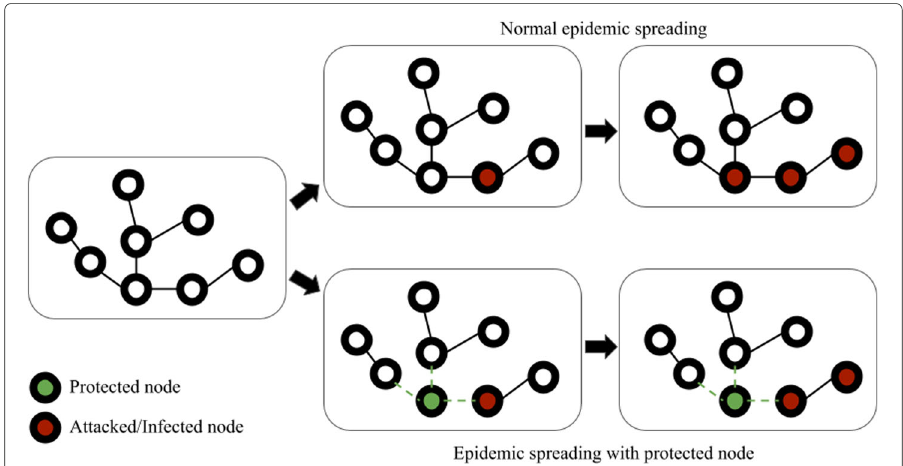
Fig. 1 Example of a static network. Green colored node indicates the node is protected. Dashed green colored edges indicate the edges are removed or inactivated because of protection. Initial red colored node on network indicates the node is attacked. Other red colored nodes indicate the nodes are